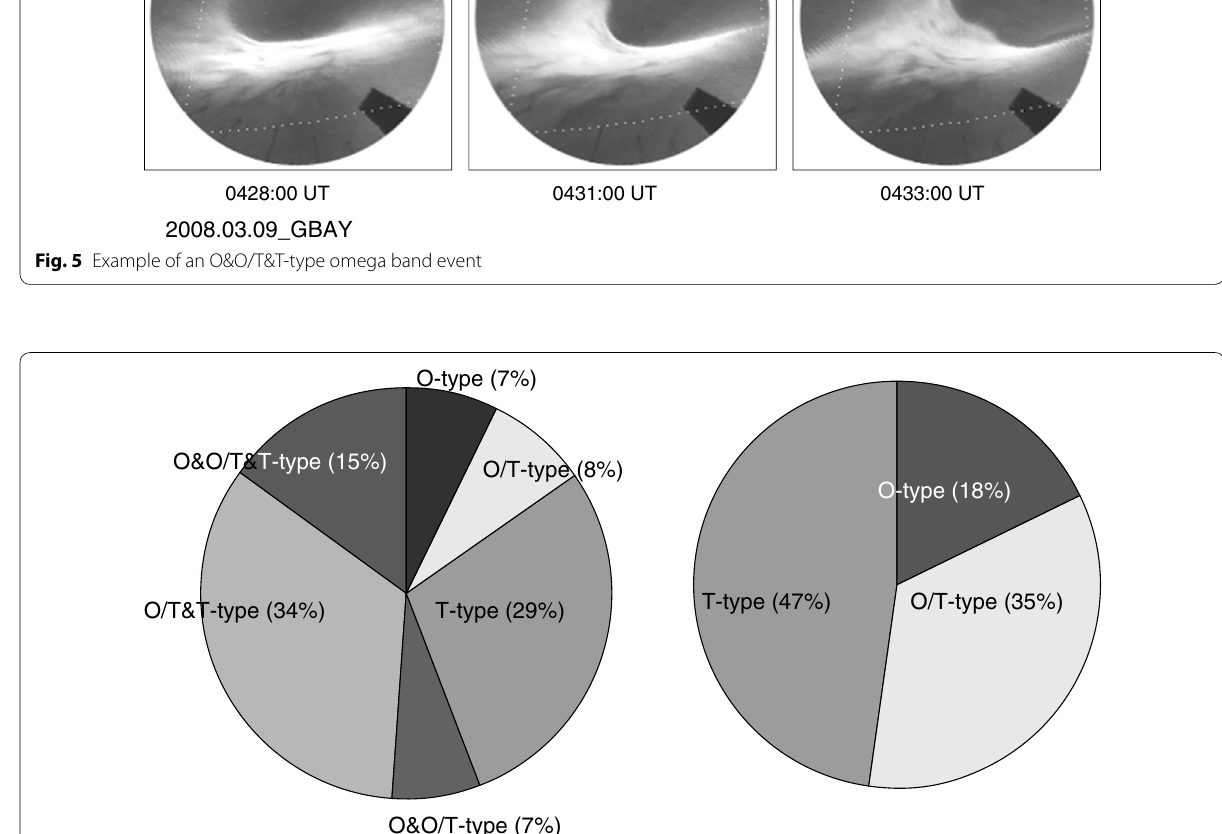
Fig. 6 Occurrence rates of the different aurora types observed in the 315 investigated events, where the left panel separately includes events in which multiple omega band types appeared, while the right panel shows only the frequencies of the three fundamental omega band